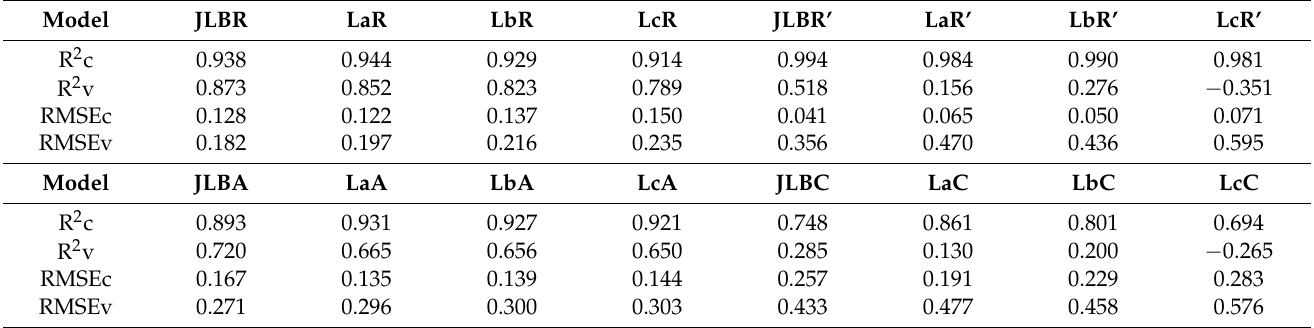
As explained in detail in Table 2, the model names in Table 3 correspond to: JLB: Jilin Benchmark Table 3. Estimation accuracy of PLS models in the light interference control experiment.